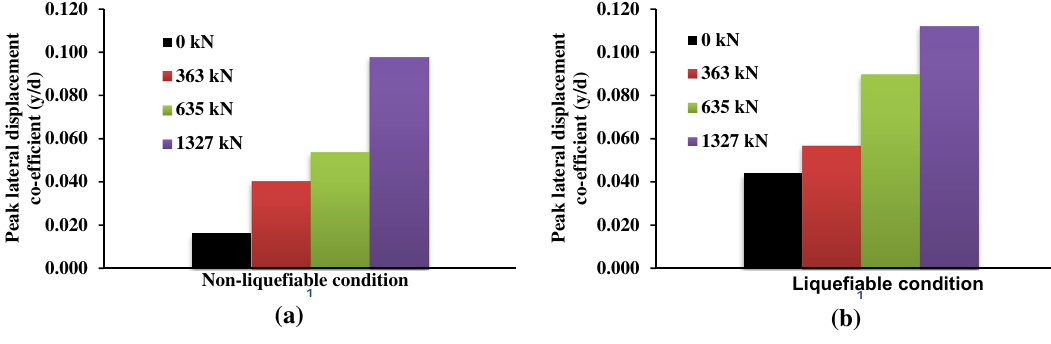
Fig. 18 Comparison of peak lateral displacement co-efficient of pile for a non-liquefiable and b liquefiable soil condition of RCD soil when subjected to scaled IMV motion